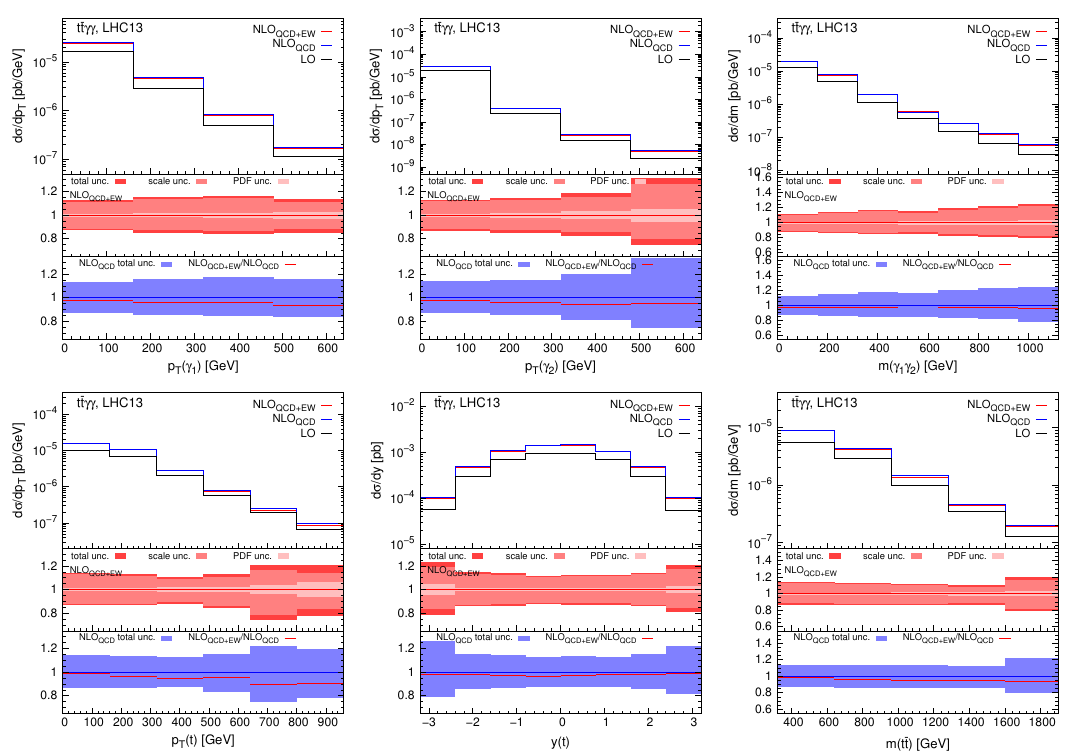
Figure 2 . Differential distributions for t ¯ tγγ